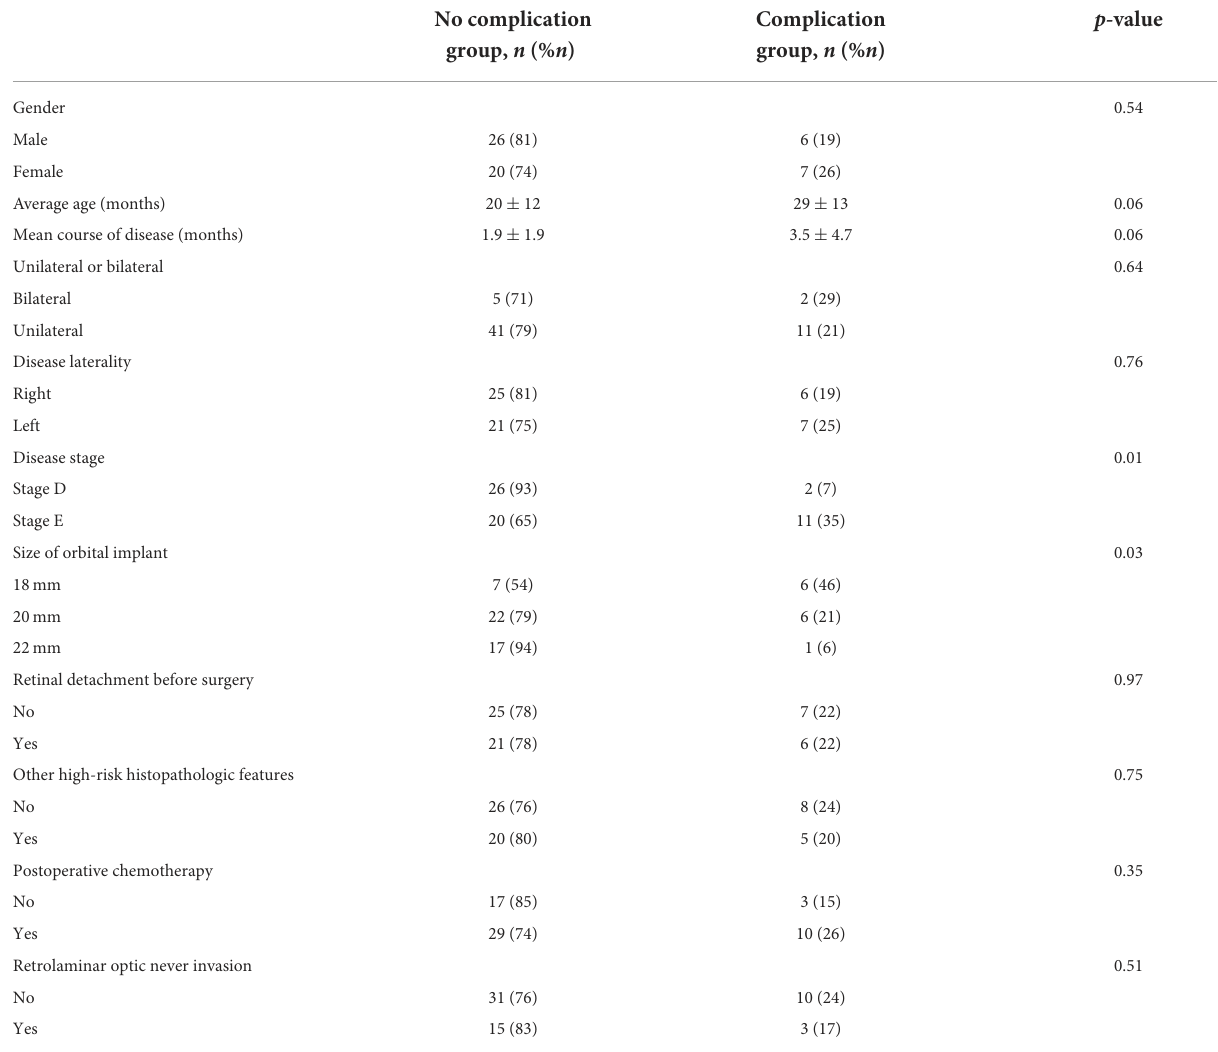
TABLE 4 Influencing factors of enucleation complications in children with RB optic nerve